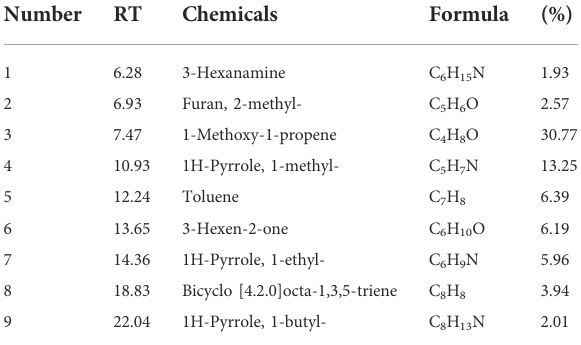
TABLE 5 Identi fi ed main components with relative area percentage in the total ion chromatogram of volatiles in the solvent collected from continuous fl ow HTL of SS at 350 ° C with 8 min RT (retention